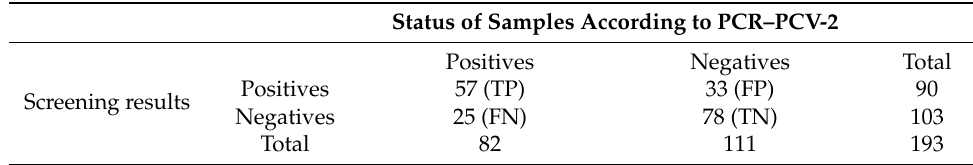
Table 5. Results of the performance assessment for PCV-2 using the POC system.